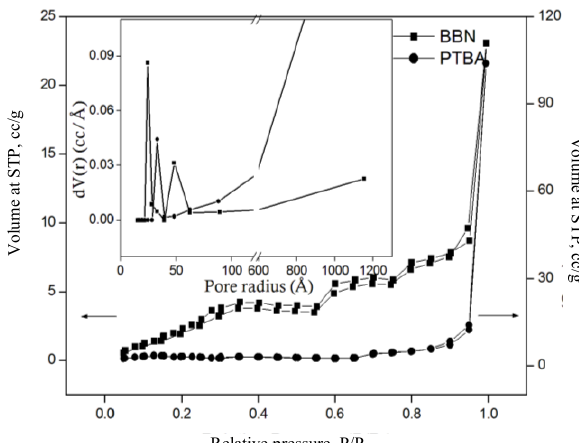
Relative pressure, P/P o